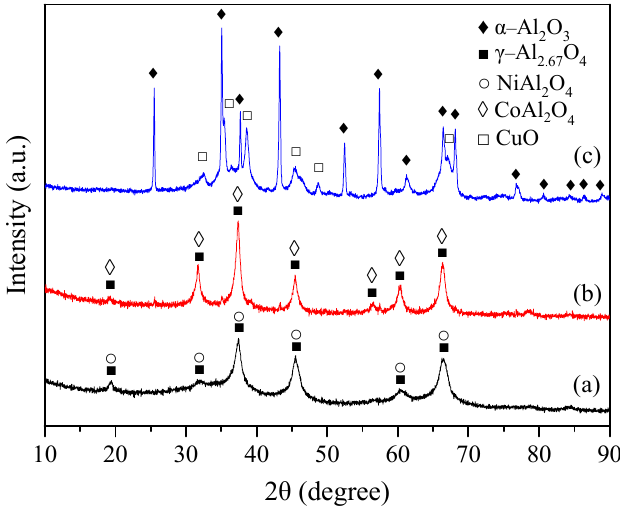
Figure 1. XRD patterns of ( a ) 10Ni − Al; ( b ) 10Co − Al and ( c ) 10Cu − Al calcined sample.